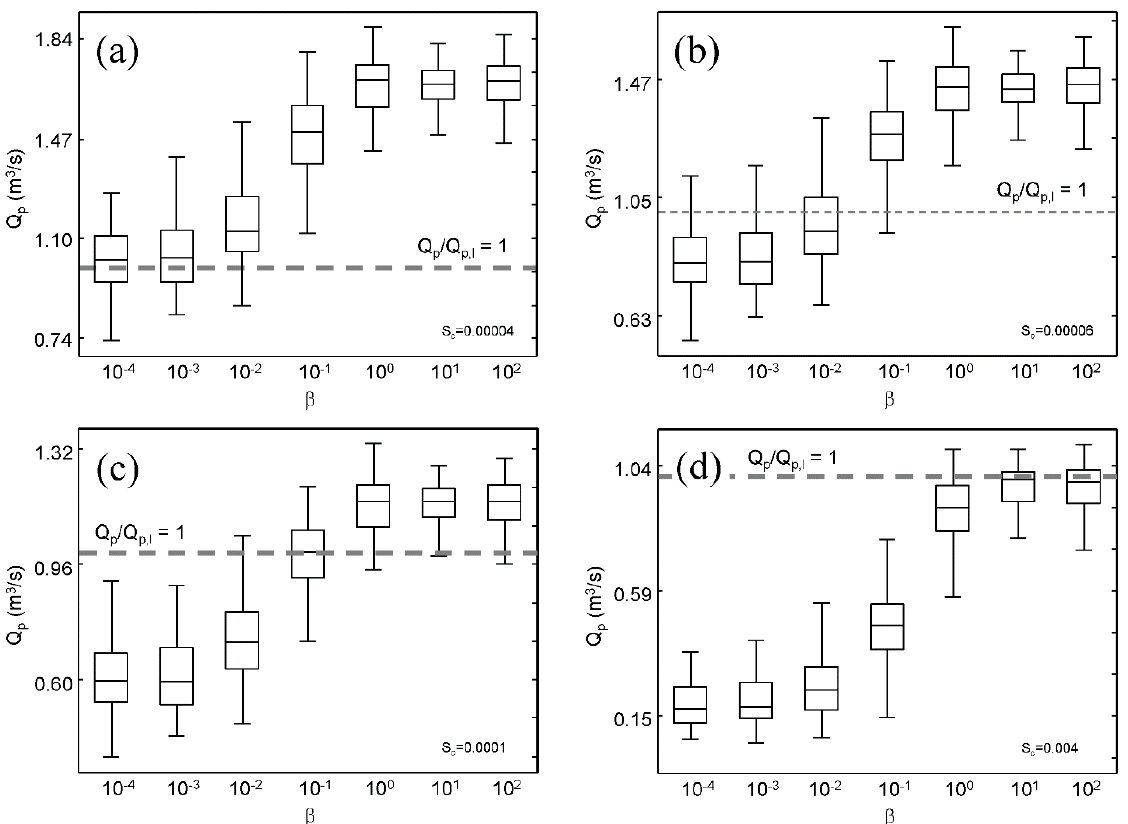
Figure 5. Behavior of the peak flow of a fully looped network depending on the catchment slope of the order of: ( a ) 4 × 10 − 5 ; ( b ) 6 × 10 − 5 ; and ( c ) 1 × 10 − 4 ; 4 × 10 − 3 (rainfall intensity = 15